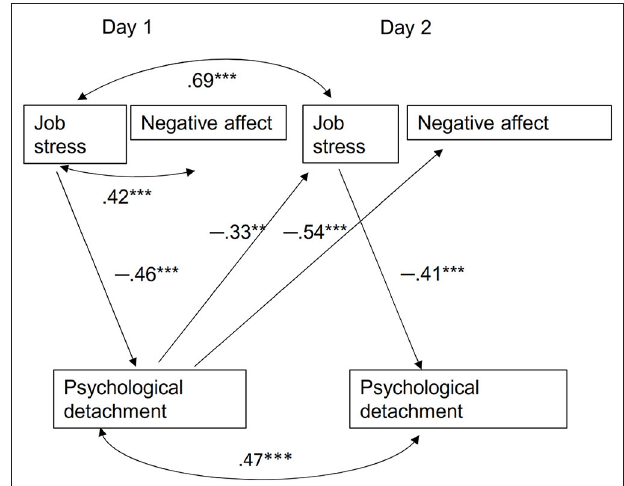
FIGURE 2 | The model with detachment as a mediator between teachers’ previous and subsequent days’ job stress and negative affect. Unidirectional arrow = β , bidirectional arrow = r ; ** p < 0.01; *** p ≤ 0.001.